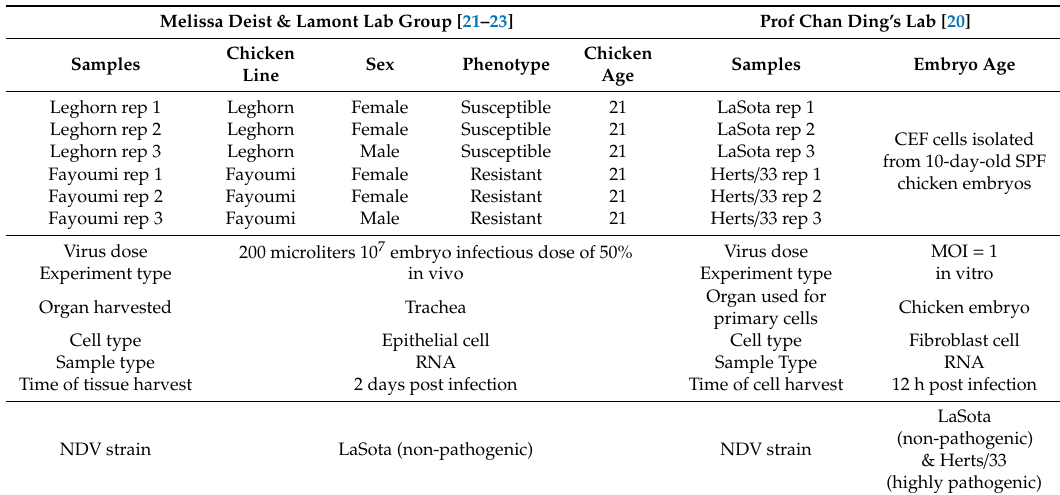
Table 1. Summary of samples used from in vivo and in vitro experiments. NDV, Newcastle disease virus; CEF, chicken embryo